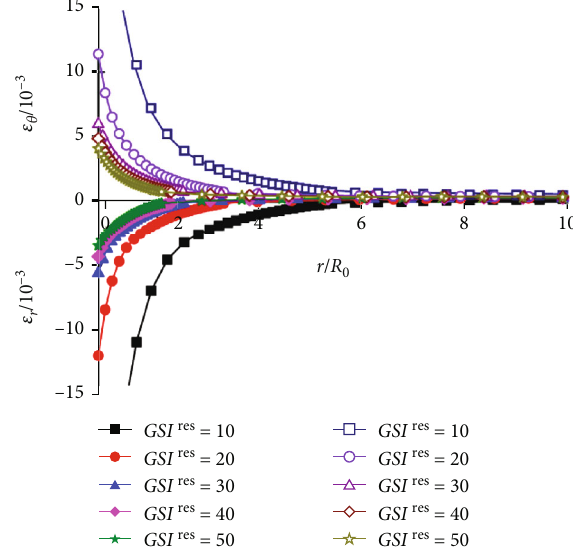
Figure 14: Strain curves with di ff erent GSI res